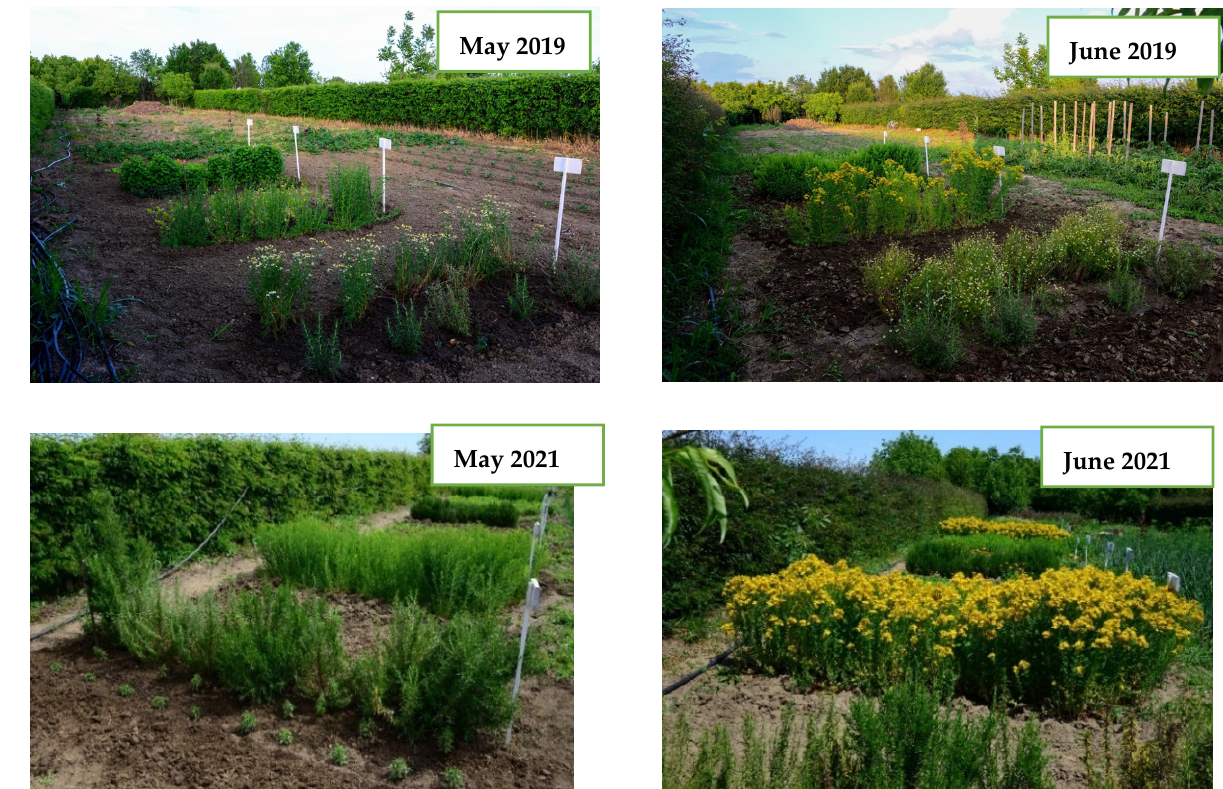
Figure 8. The evolution and dynamics of the whole culture during our study.